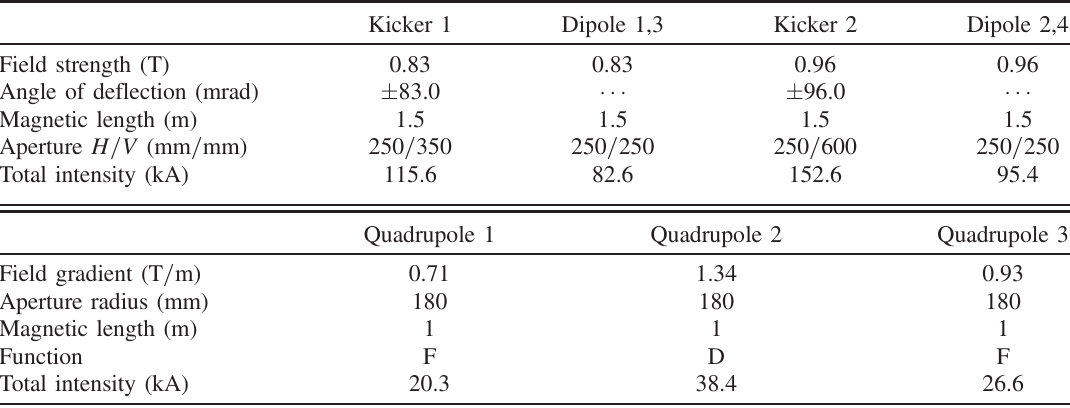
TABLE III. Summary of the physical parameters of: kicker 1,2 and dipole 1,2,3,4 (top), quadrupole 1,2,3 (bottom) of the 4 beam lines.